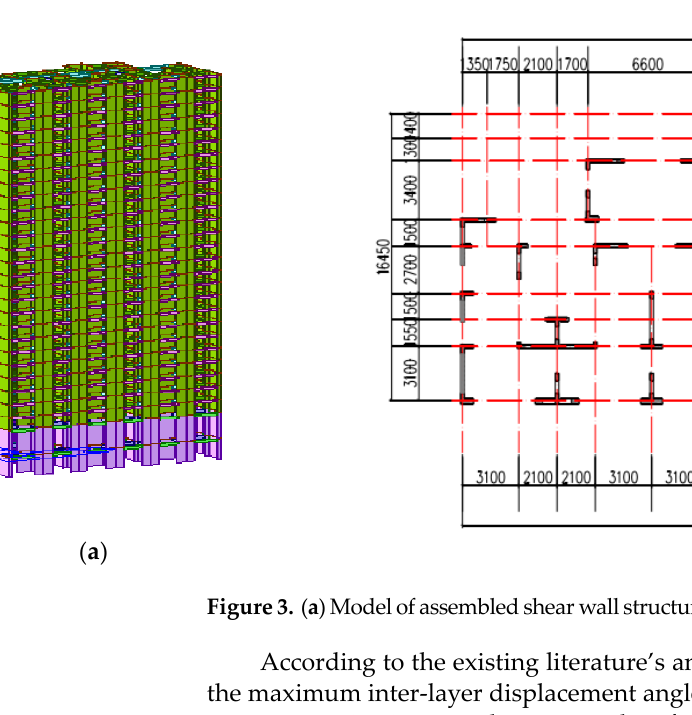
Figure 2. 3D wall unit.